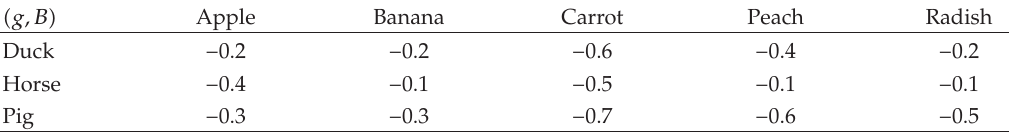
Table 2: Tabular representation of (cid:2) g,B (cid:3)